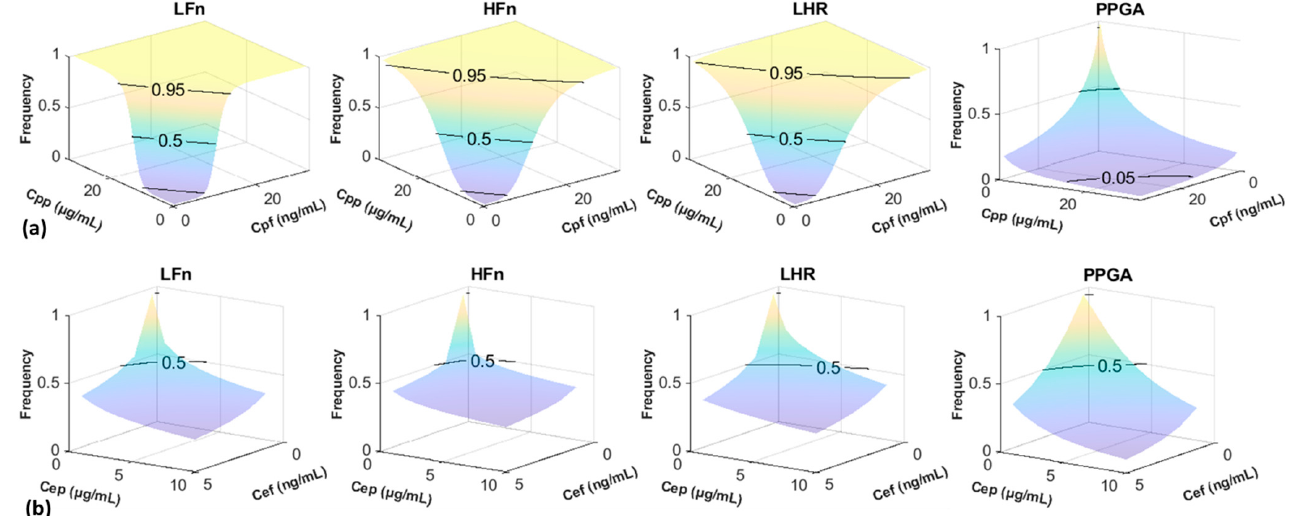
Figure 2. ( a , b ) The three-dimensional morphologies of activities on the ANS in terms of plasma concentrations (Cp) and effect-site concentrations (Ce), respectively. The level contours exhibit the corresponding performance of the drug interaction. Panel ( b ) exhibits only the mixed morphologies of Groups 1 and 2. Table 2. The modeling and sampling parameters of the propofol–fentanyl interaction MLRSM.